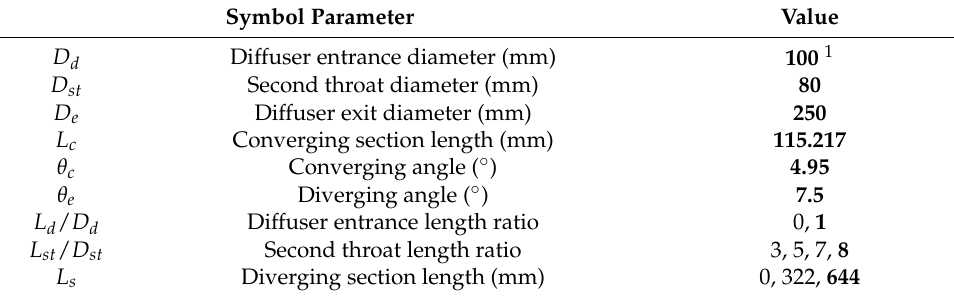
Figure 1. Geometric configuration and main design parameters of the STED. Table 1. Design parameters of the STED.